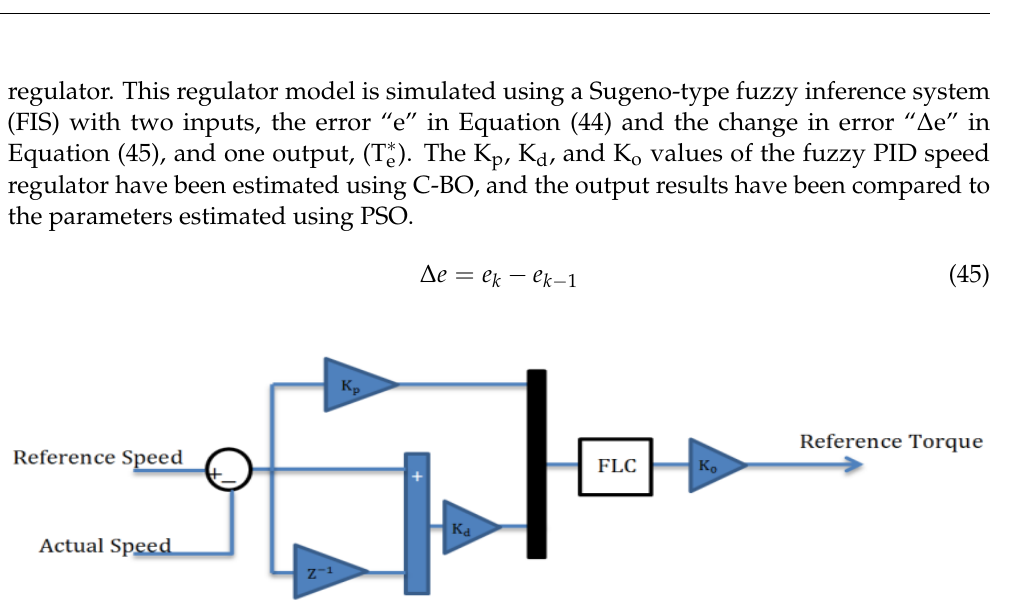
Figure 13. Block diagram of fuzzy PID speed regulator.